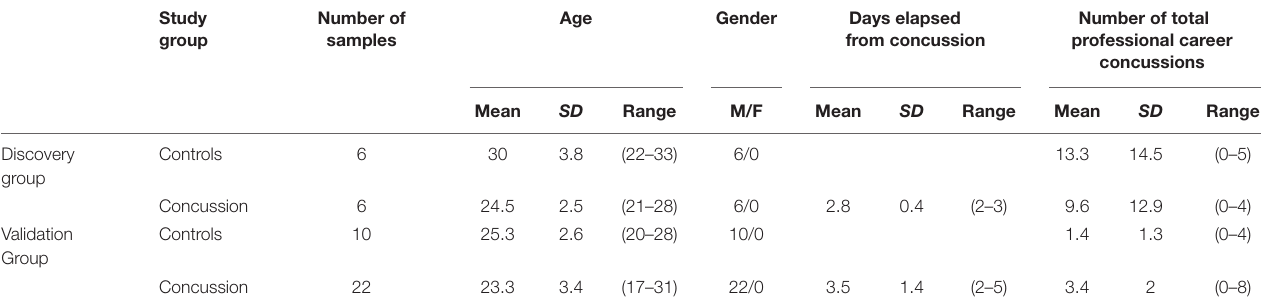
TABLE 1 | Clinical and demographic characteristic of the study subjects included in the analysis of microRNA.